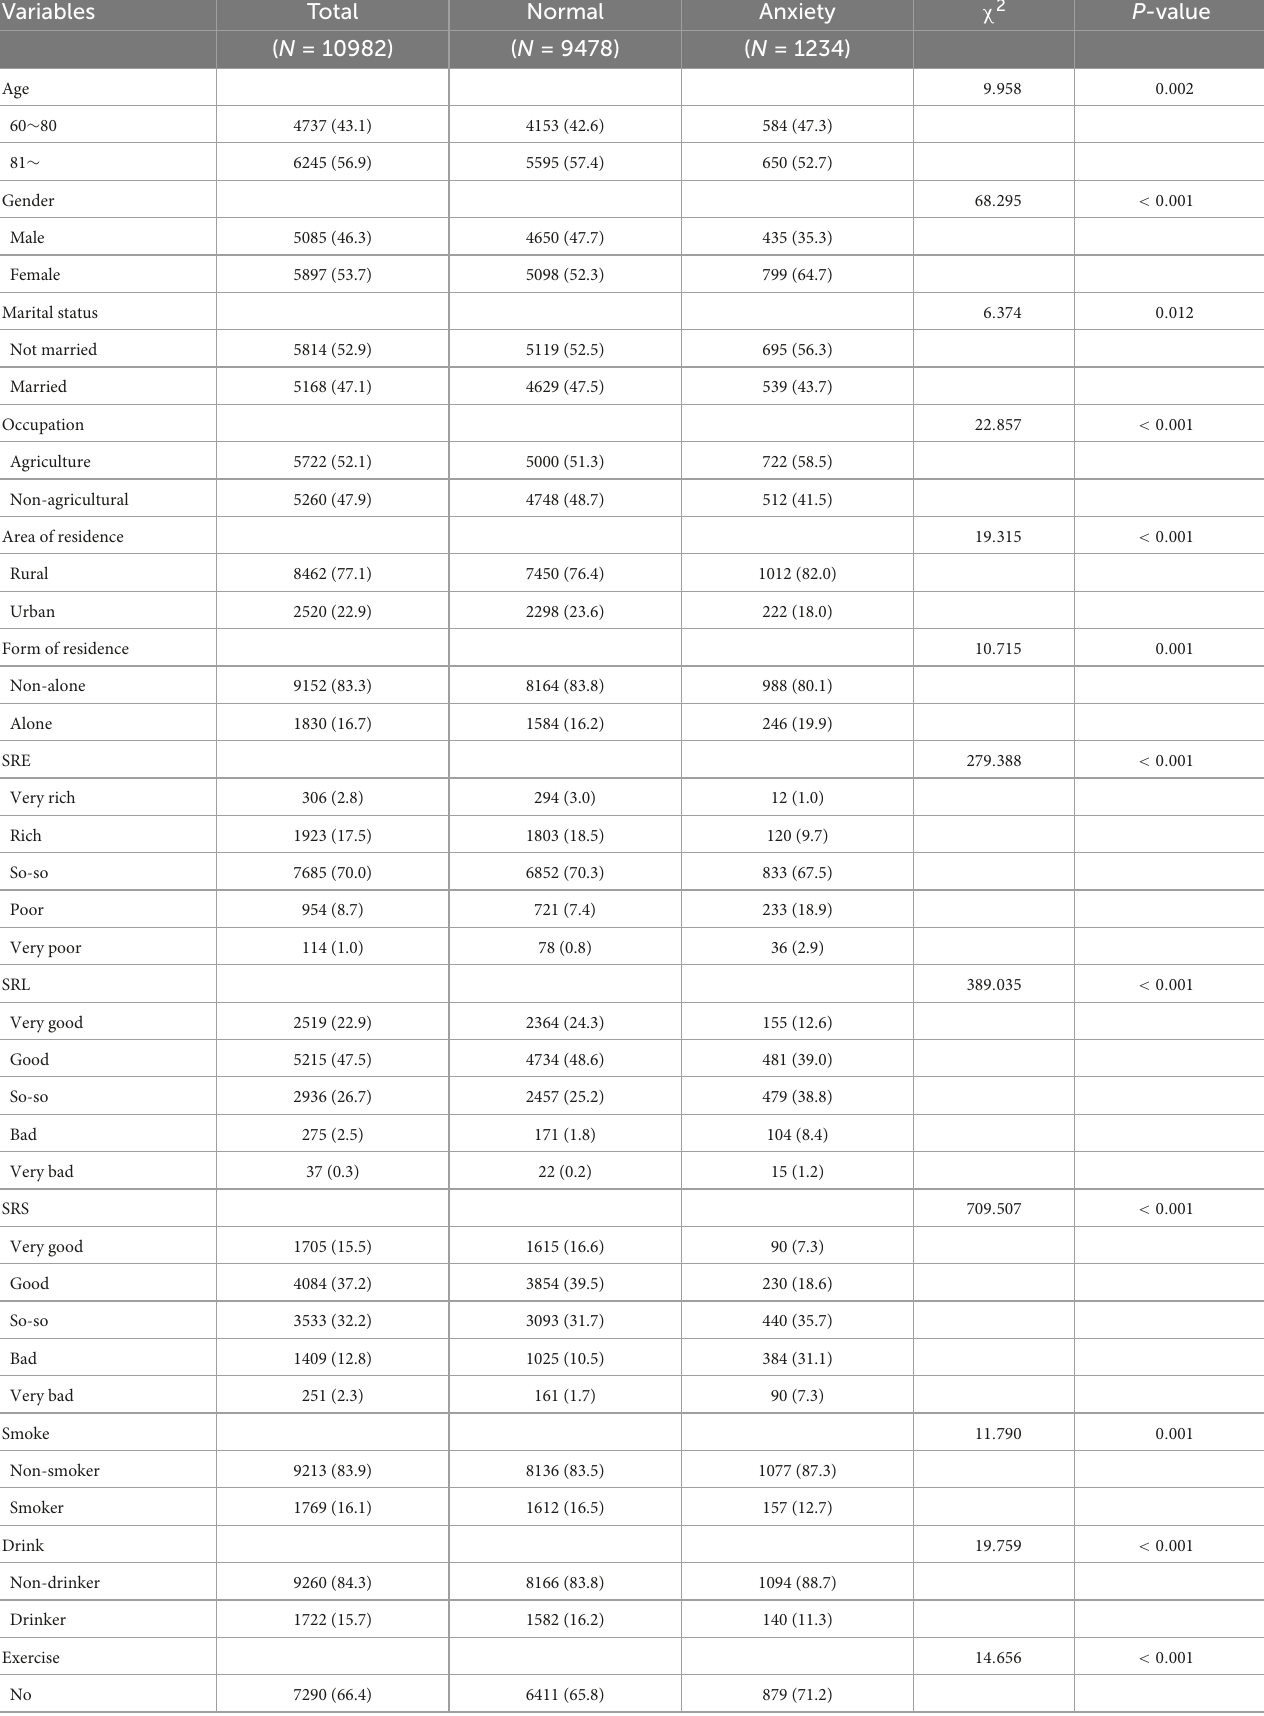
TABLE 1 The demographic characteristics distribution of anxiety among the elderly and univariate analysis. Variables Total